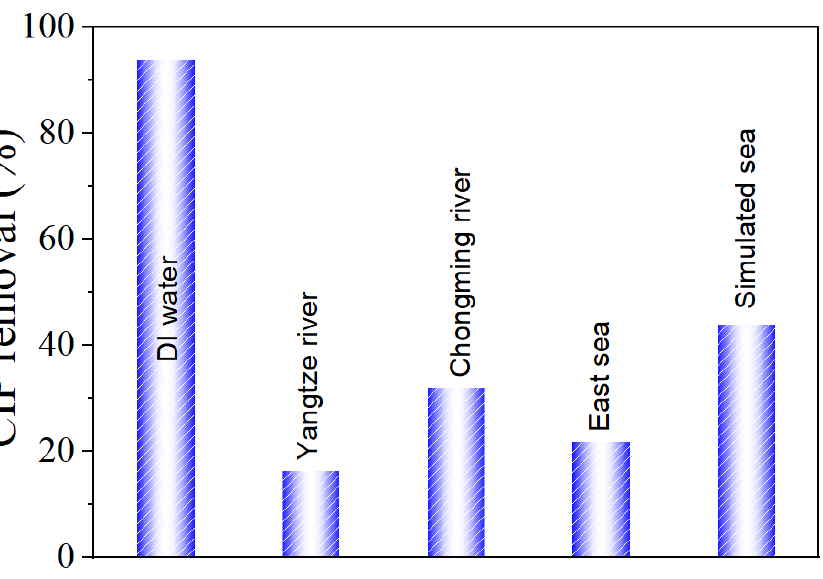
Figure 9. The effect of real water matrix on CIP in GQDs/ α -FeOOH + H 2 O 2 systems under visible light irradiation.